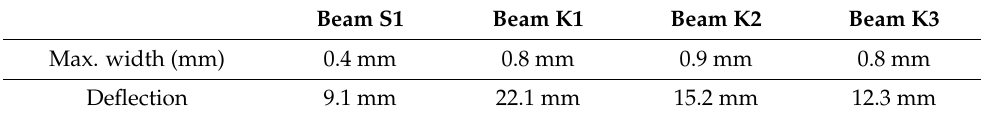
Table 3. Maximum crack width and deflection before